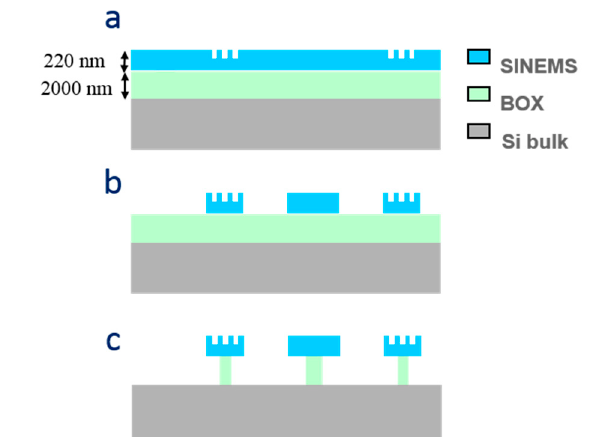
Figure 2. Fabrication process of the optomechanical devices. ( a ) Partial silicon ICP etching to pattern grating couplers; ( b ) Patterning of the optical waveguides and microdisk resonators by ICP etching; ( c ) Microdisks release using vapor HF